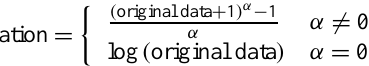
Figure 8. Characteristics of each time series class. Upper panel: first class; middle panel: second class; lower panel: third class.